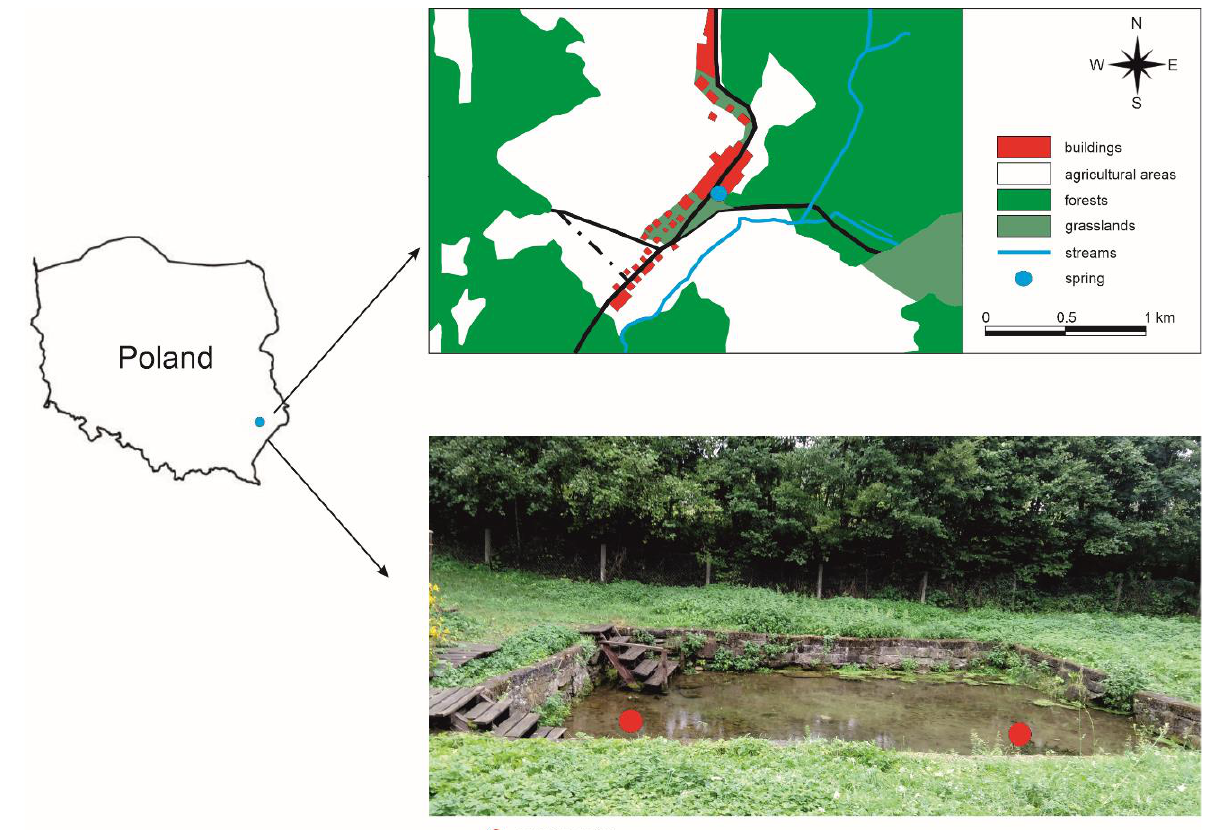
Figure 1. Location of Górecko spring and sampling points.